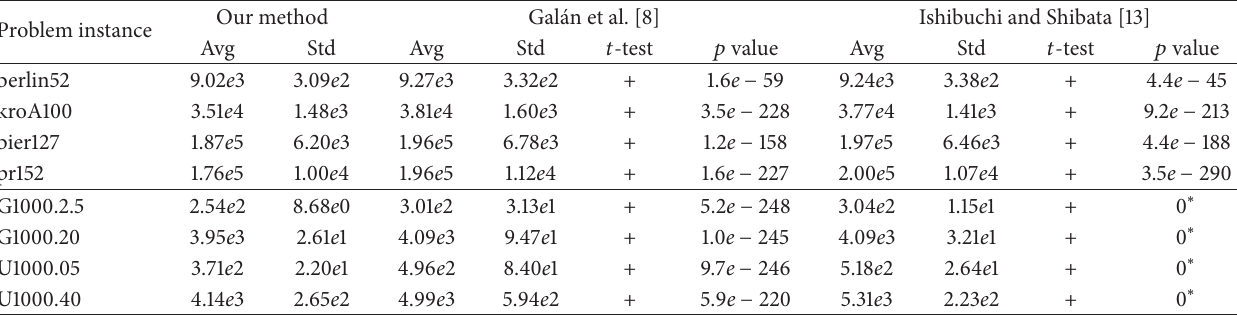
Table 6: Comparison of results on two test